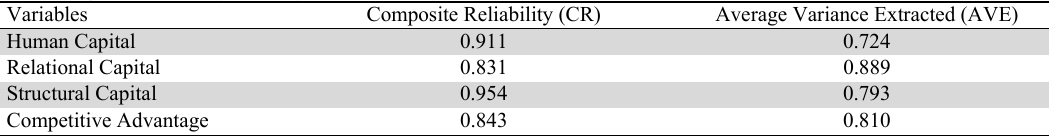
Convergent Validity